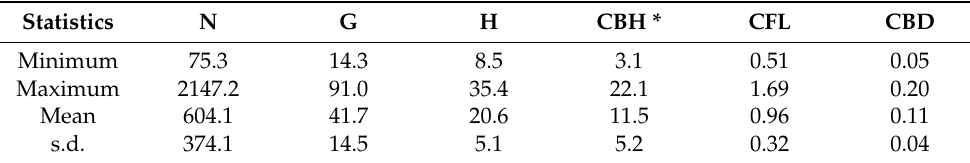
Table 5. Descriptive statistics of stand variables obtained in the 2009/2010 field inventory plots ( n = 202). N, stand density (trees/ha); G, basal area (m 2 /ha); H, Stand height (m); CBH, canopy base height (m); CFL, canopy fuel load (kg/m 2 ); CBD, canopy bulk density (kg/m 3 ); s.d., standard